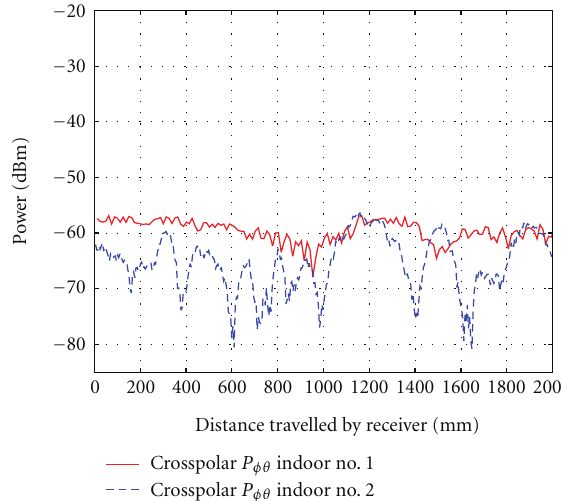
Figure 4: Power variation against distance of the cross-polar re- ceived signal envelope at